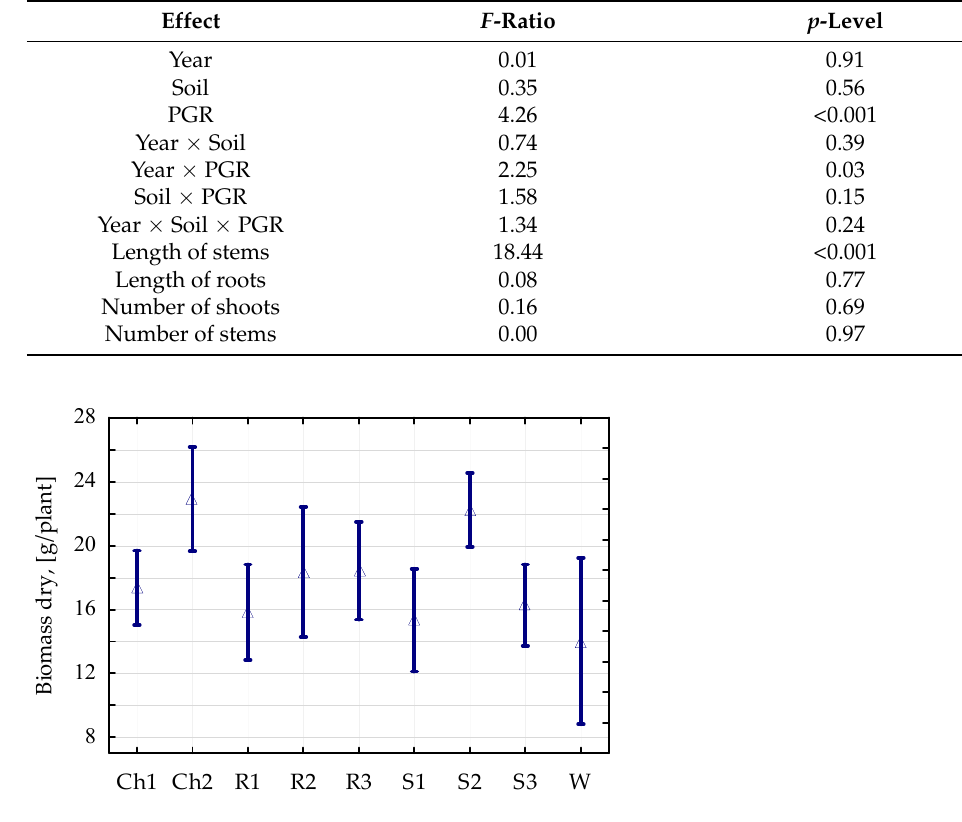
Table 5. Evaluation of the effect of the research factors, PGRs, soil type, and year of vegetation, on